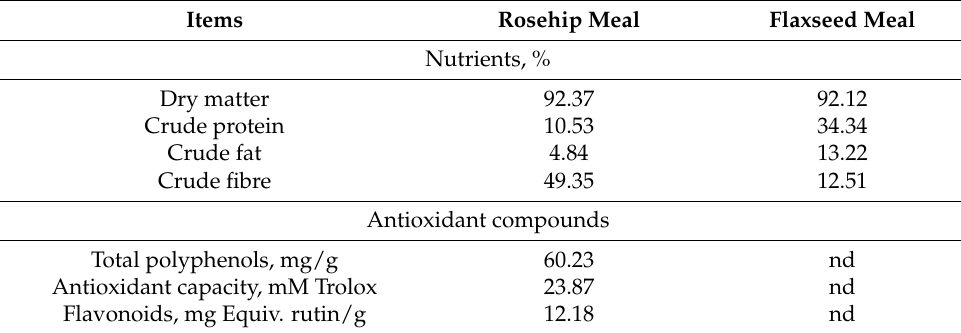
Table 2. Primary chemical composition, antioxidant compounds, fatty acids, and amino acids determined in rosehip meal and flaxseed